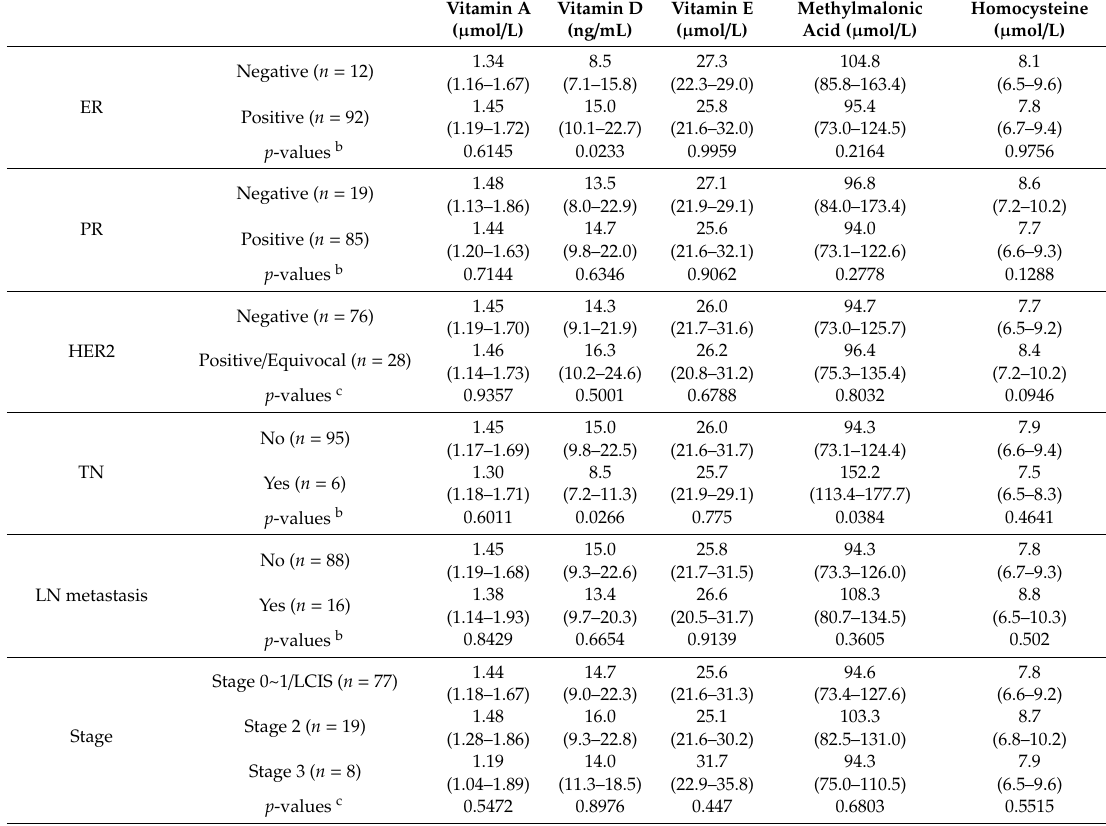
Table 4. Subgroup analyses of vitamin levels in 104 breast cancer patients a